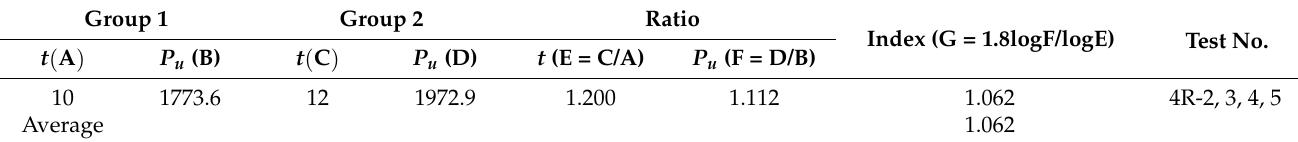
Table 14. Index value for the variable of t